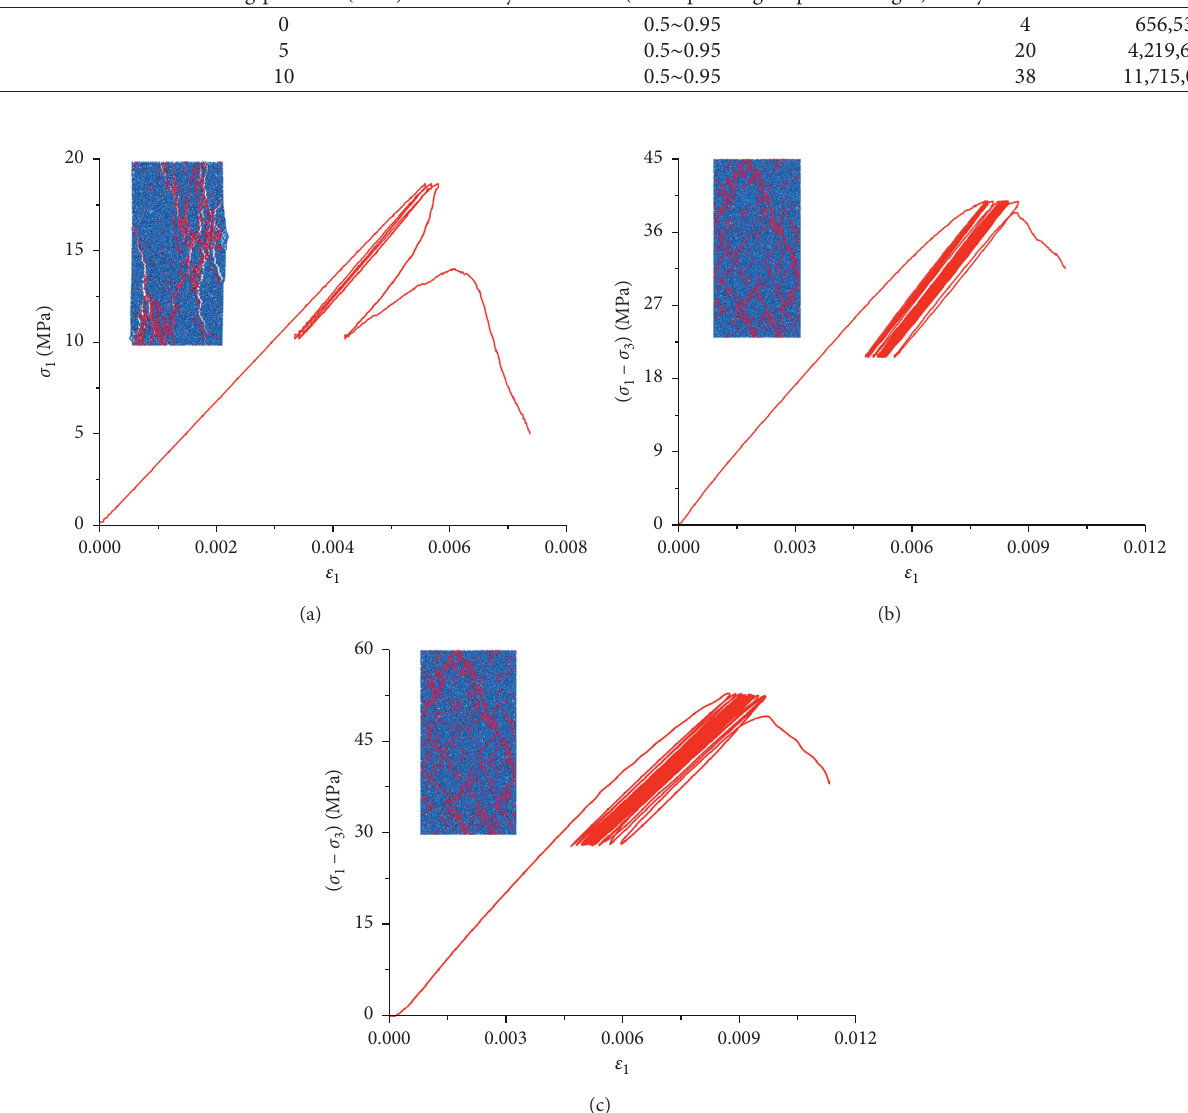
Figure 4: The axial stress- strain curves under different confining pressures: (a) 0MPa, (b) 5MPa, and (c)